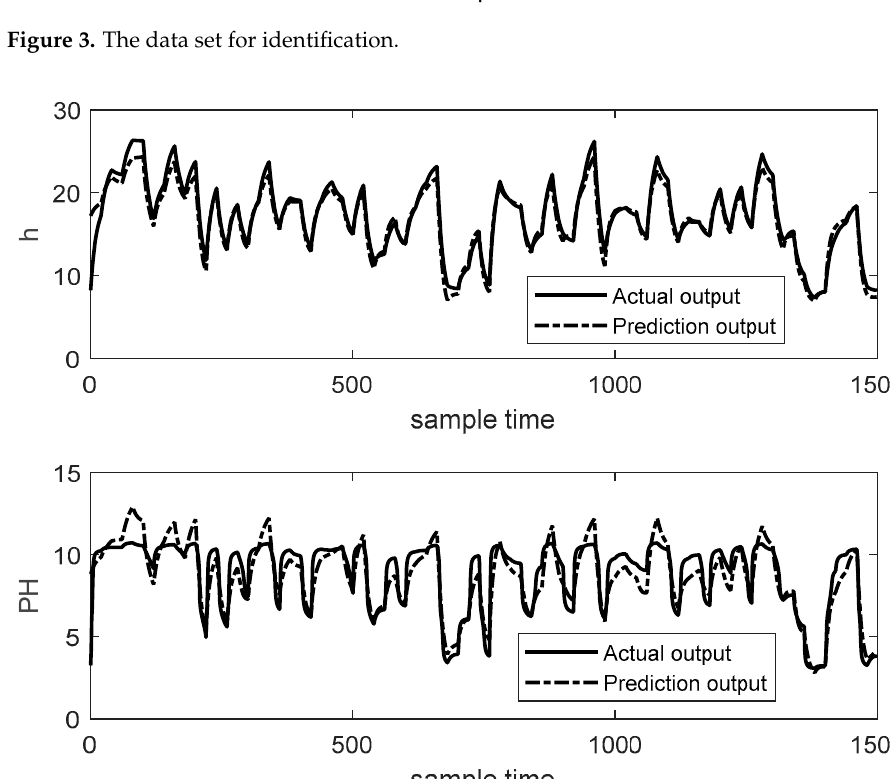
Figure 4. Cross-validation results of the proposed method.